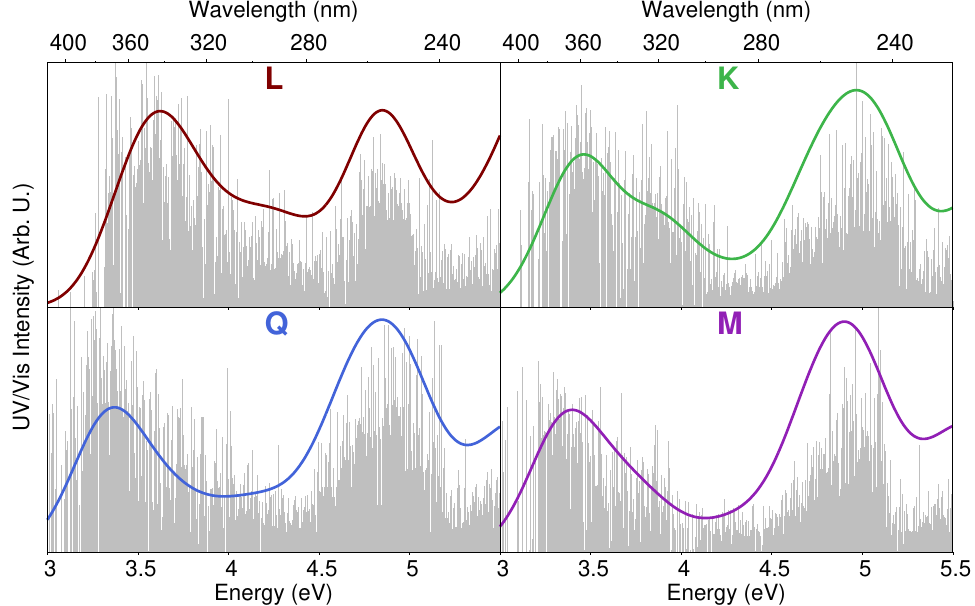
Figure 6. QM/FQ UV/Vis stick spectra of each studied flavonoid computed on 300 snapshots extracted from MD noVS . Convoluted QM/FQ spectra are also plotted in color.